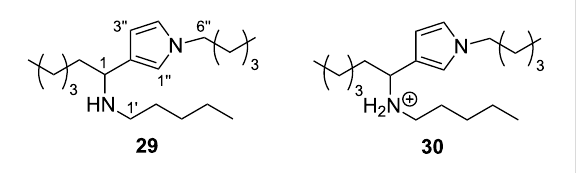
Figure 3: Pyrrole product 29 and salt 30 obtained from the reaction of dialdehyde 11 with n -pentylamine.